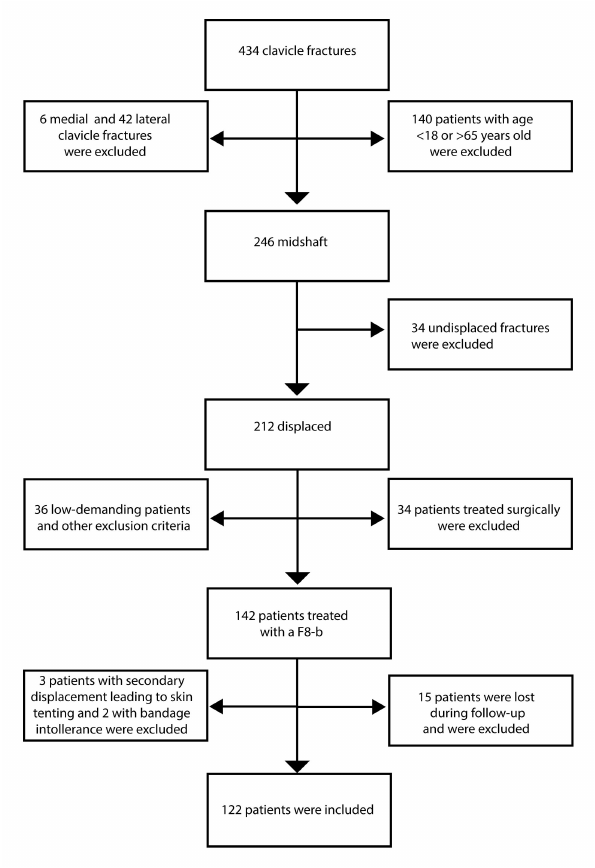
Figure 2. Flowchart illustrating patient selection.